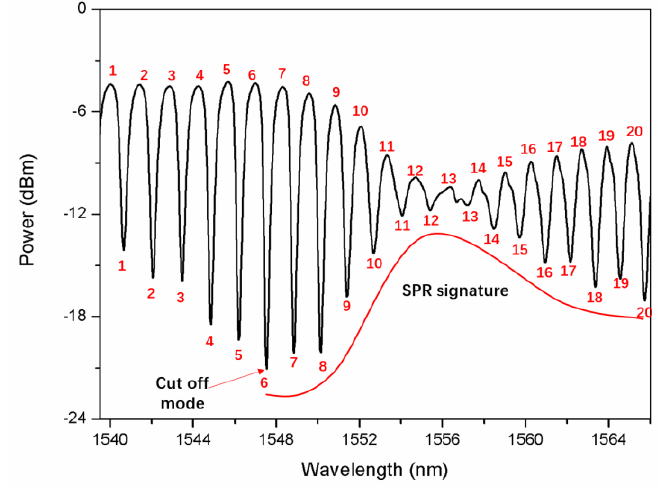
Figure 5. Max-peaks and min-peaks with serial numbers, such as 1, 2, 3, etc., in the initial glucose aqueous solution with a SRI of ~1.3573.